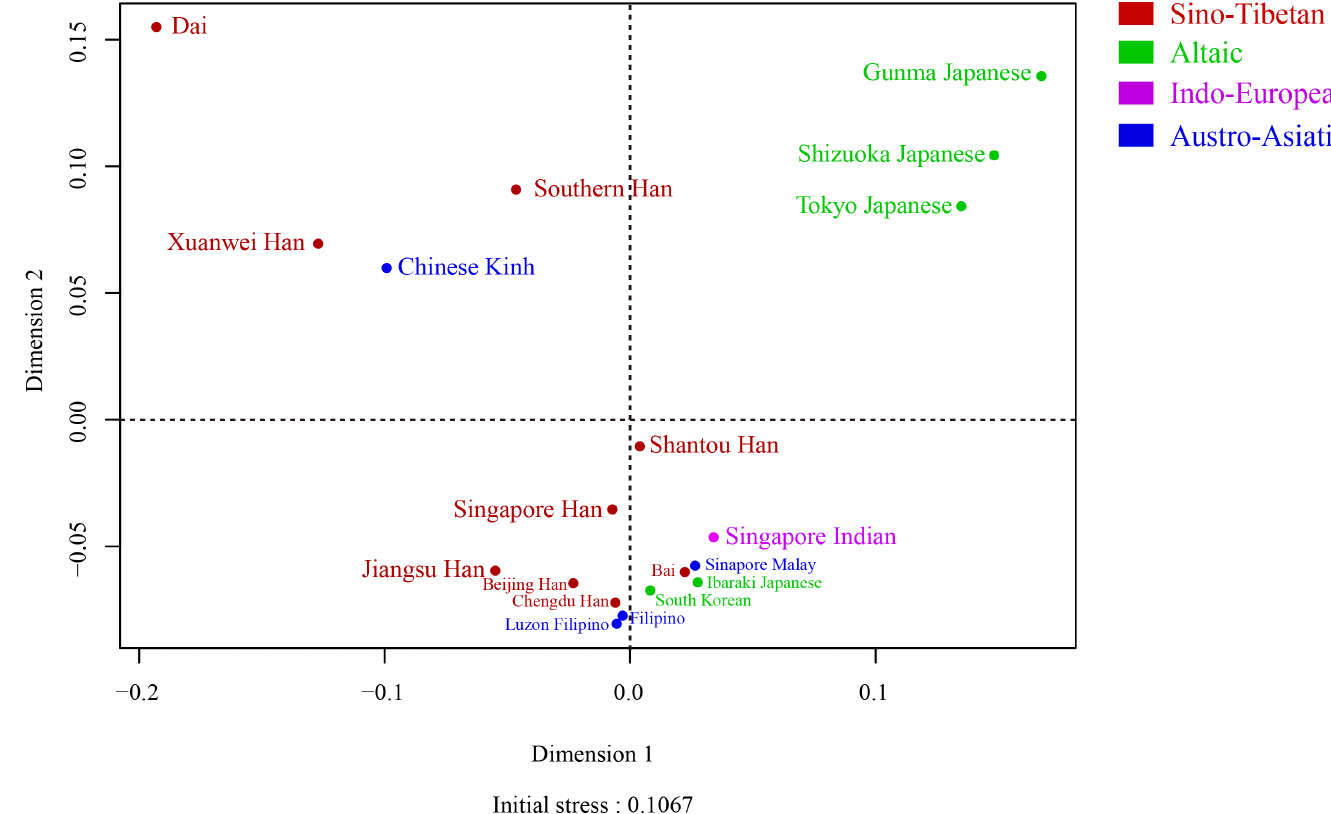
PLOS ONE | https://doi.org/10.1371/journal.pone.0180921 July 13,